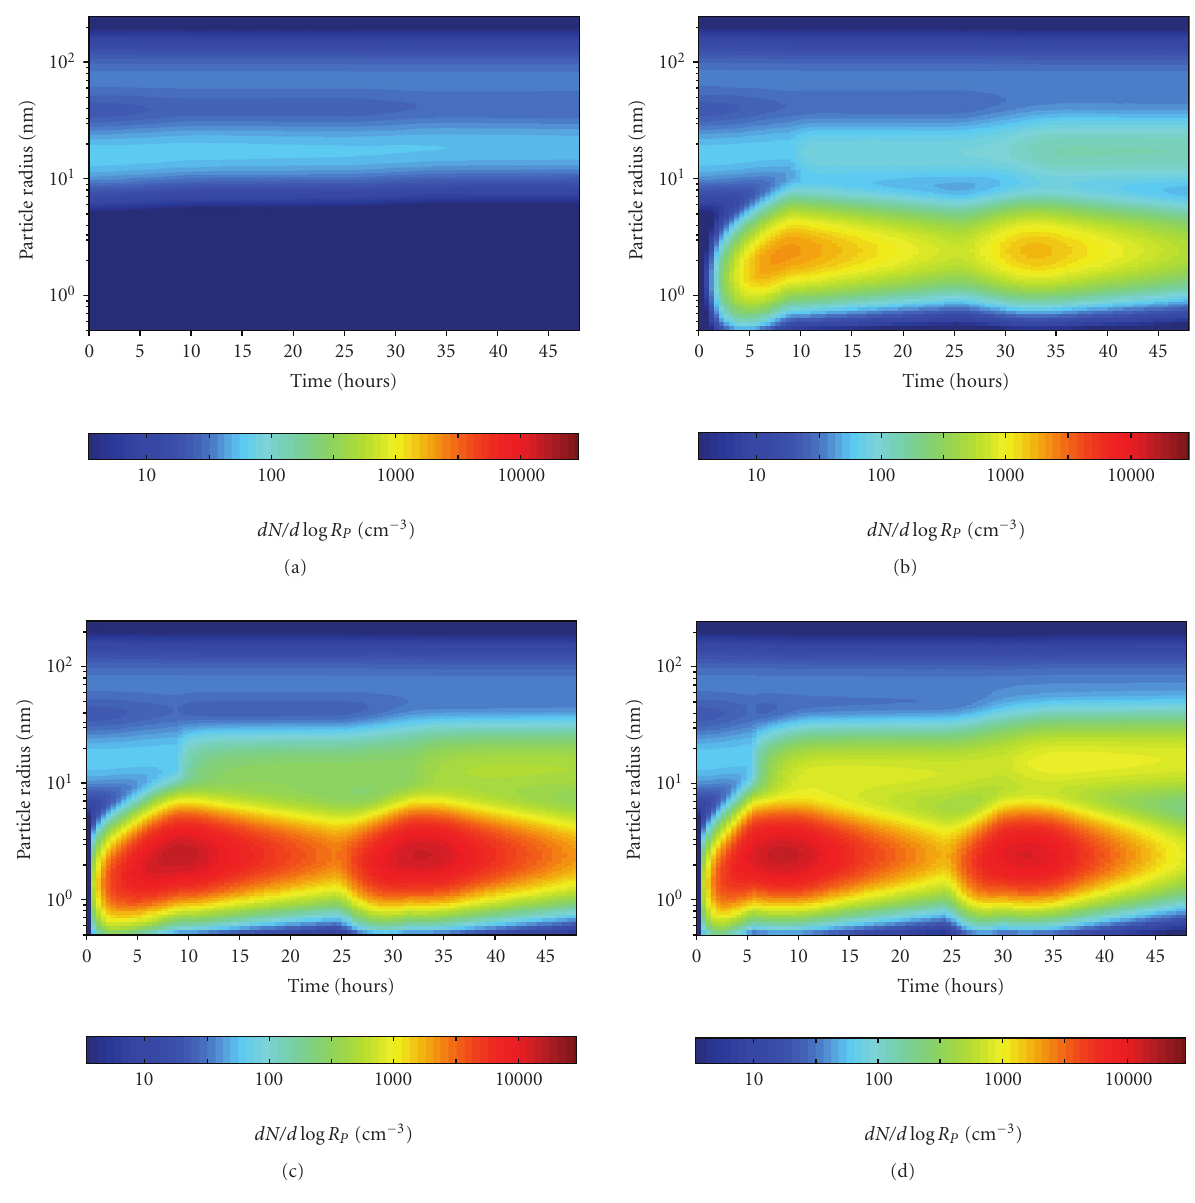
Figure 2: (a) Base case of H 2 SO 4 growth without nucleation (b) kinetic self (OIO) nucleation and growth (c) H 2 SO 4 -OIO nucleation and (d) H 2 SO 4 -OIO nucleation plus condensation of organic vapours.